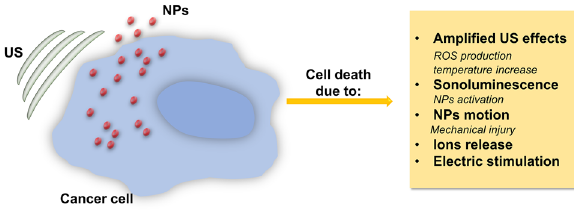
Fig. 10 Summary of possible mechanisms to explain the cytotoxicity arising from NP-assisted US